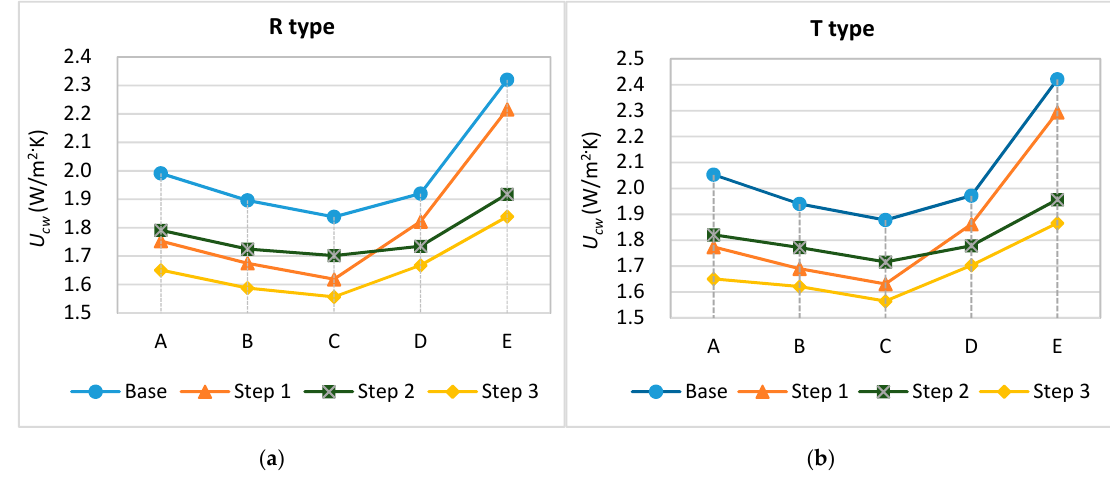
Figure 7. Comparison of U CW according to the materials for the gasket and the cover cap. ( a ) R type profile; and ( b ) T type profile.